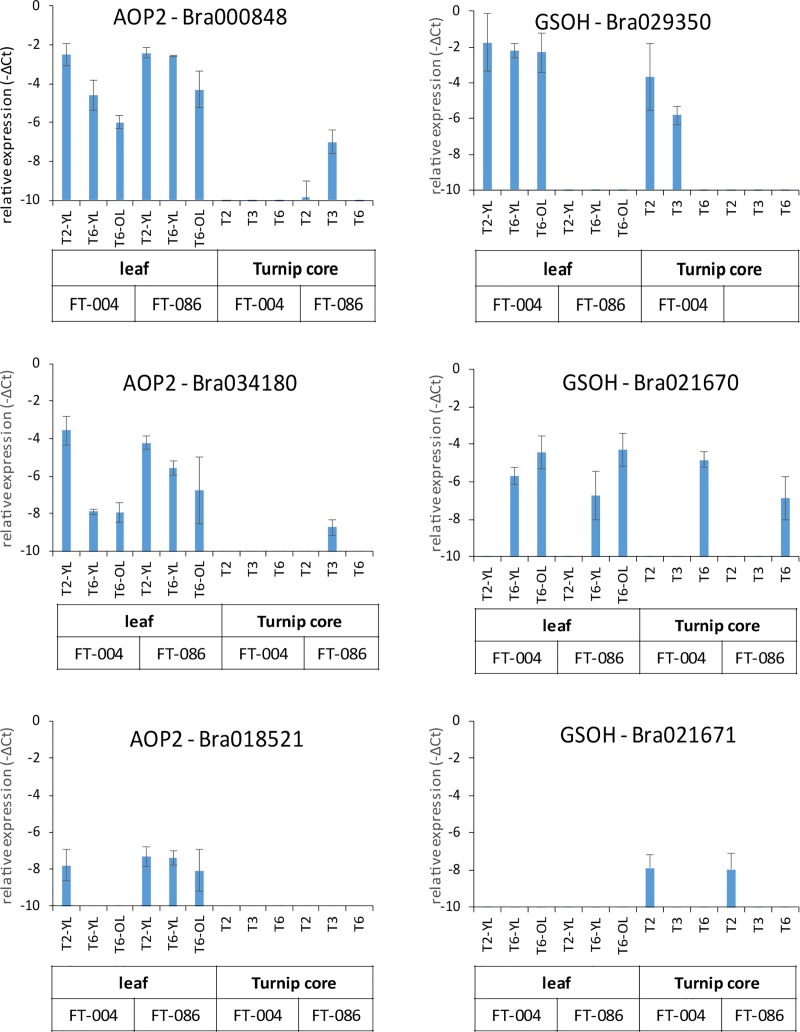
Gene expression analysis of AOP2 and GS-OH paralogues in selected turnip tissues and timepoints in accessions FT-004 and FT-086.Indicated are the expression levels relative to the reference gene (actin) on a logarithmic scale. Error bars indicate standard deviations (n = 3). YL: young leaf; OL: old leaf. For timepoints see legend Fig 2.